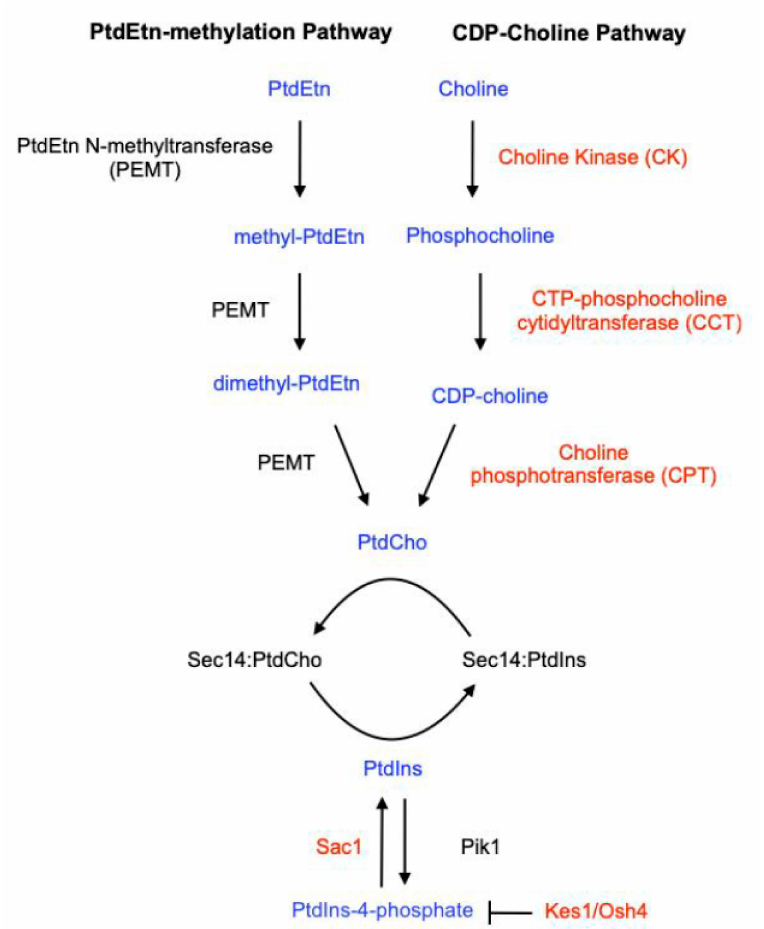
Figure 11. Mechanisms for “bypass Sec14”. Loss-of-function mutations in specific non-essential genes restores cell viability in the face of functional ablation of the normally essential Sec14. These “bypass Sec14” mutations affect the individual metabolism of both phospholipid binding ligands of Sec14. The affected pathways are shown in simplified form. Mutations that affect PtdCho metabolism specifically inactivate the CDP-choline pathway for PtdCho biosynthesis, the enzymes of which are highlighted in red. Interestingly, ablation of the de novo phosphatidylethanolamine (PtdEtn) methylation pathway for PtdCho biosynthesis, even under conditions where this pathway is the sole pathway for net production of PtdCho, has no effect on the cellular requirement for Sec14 function. Loss-of-function mutations that impact inositol phospholipid metabolism do so via inactivation of antagonists of PtdIns(4)P signaling. These include mutations that functionally ablate the Sac1 PtdIns(4)P phosphatase Sac1 and or the PtdIns(4)phosphate/sterol exchange protein Kes1/Osh4— also highlighted in